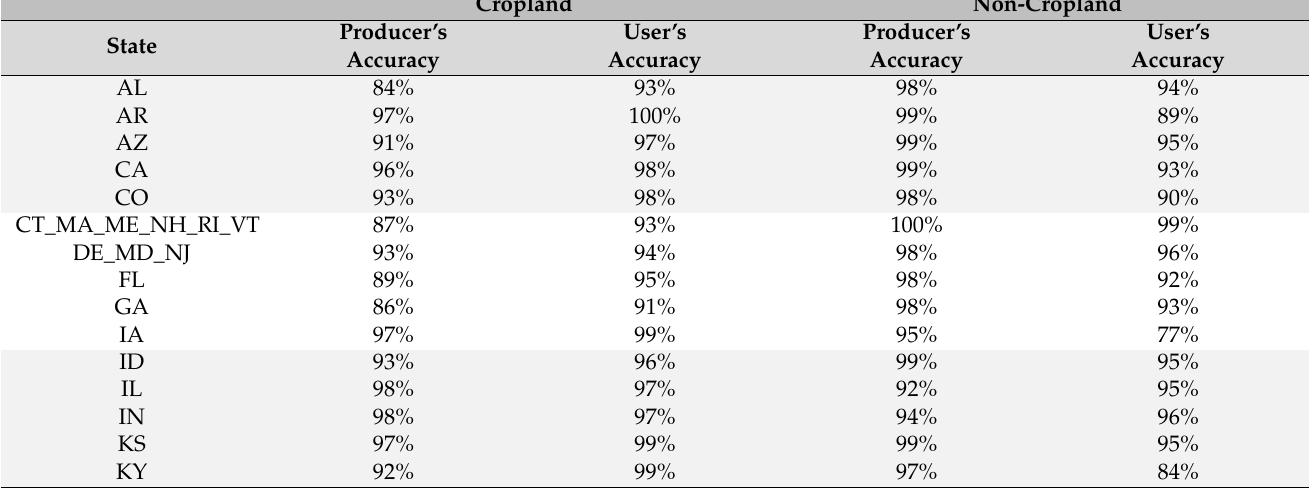
Table A3. Accuracy of CDL-derived consolidated cropland and non-cropland classifications for each U.S. state or multistate region for 2012. Results calculated according to Equation (4) and consolidated according to Appendix A Table